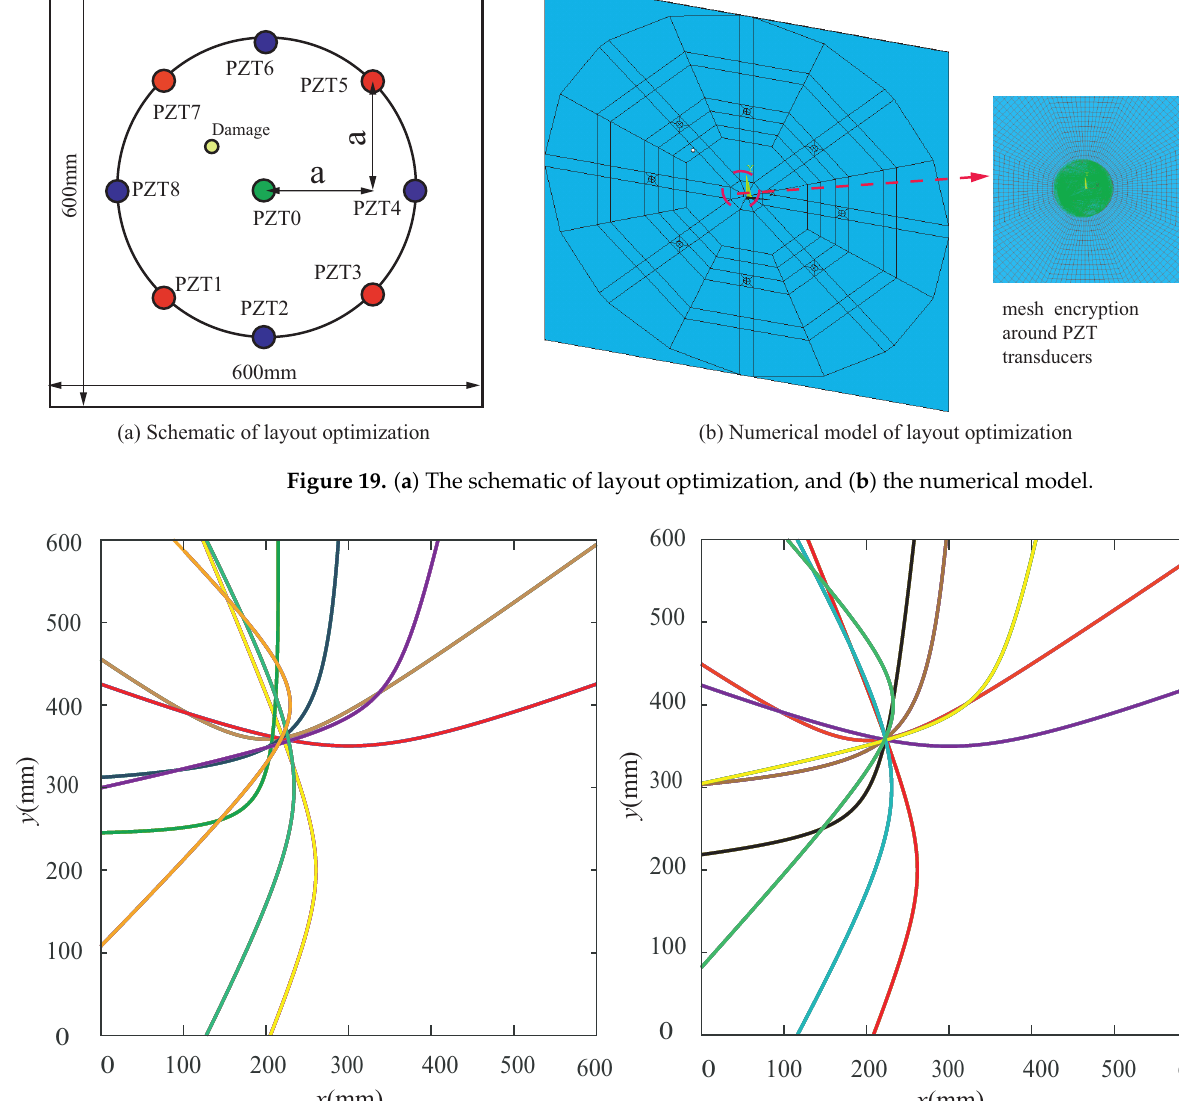
hyperbolas can be drawn by another four sensors. The hyperbolas of the experiment and simulation are shown in Figure 20.